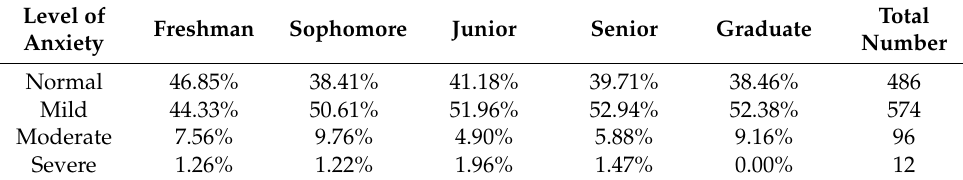
Table 3. Distribution of anxiety by the grade.